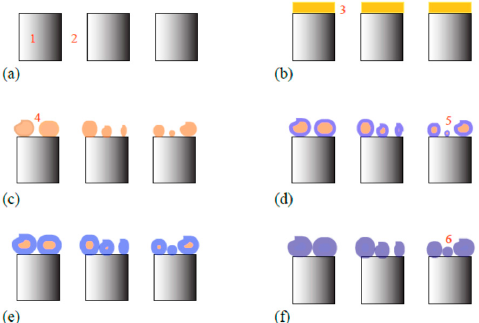
Figure 4. Schematic showing the gold catalyst assisted chemical vapor deposition mechanism: ( a ) porous AAO; ( b ) AAO coated with Au layer; ( c ) self-assembling of Au layer into nanoparticles at elevated temperatures; ( d ) Bi-Te-Ni-Cu growth around Au; ( e ) reaction of Bi-Te-Ni-Cu with Au to form alloy; and ( f ) homogenization of the complex material to form island like feature. 1: AAO wall, 2: AAO pore, 3: gold layer, 4: gold nanoparticles, 5: interface layer of Bi-Te-Ni-Cu and Au, 6: fully homogenized Bi-Te-Ni-Cu-Au coating.